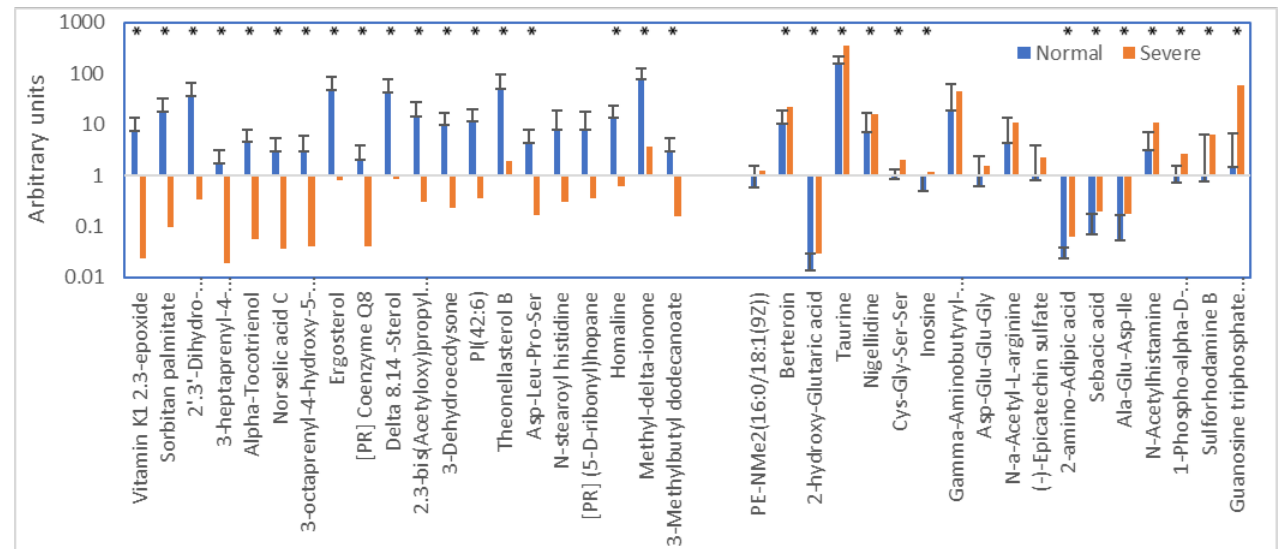
Figure 3. Metabolites most strongly decreased (<5% vs. normal) and most strongly increased (>100% vs. normal) as a result of WB (* p < 0.05).